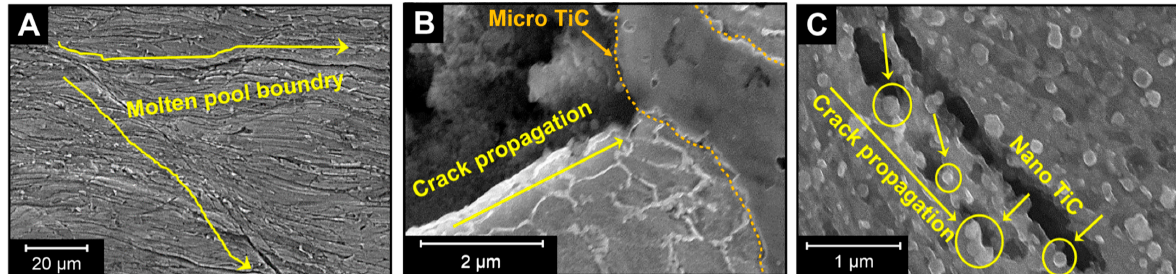
Figure 6. SEM image of crack propagation with ( A ) LBPBF 316L; ( B ) LBPBF micro-TiC/316L composite and ( C ) LBPBF nano-TiC/316L composite [69].